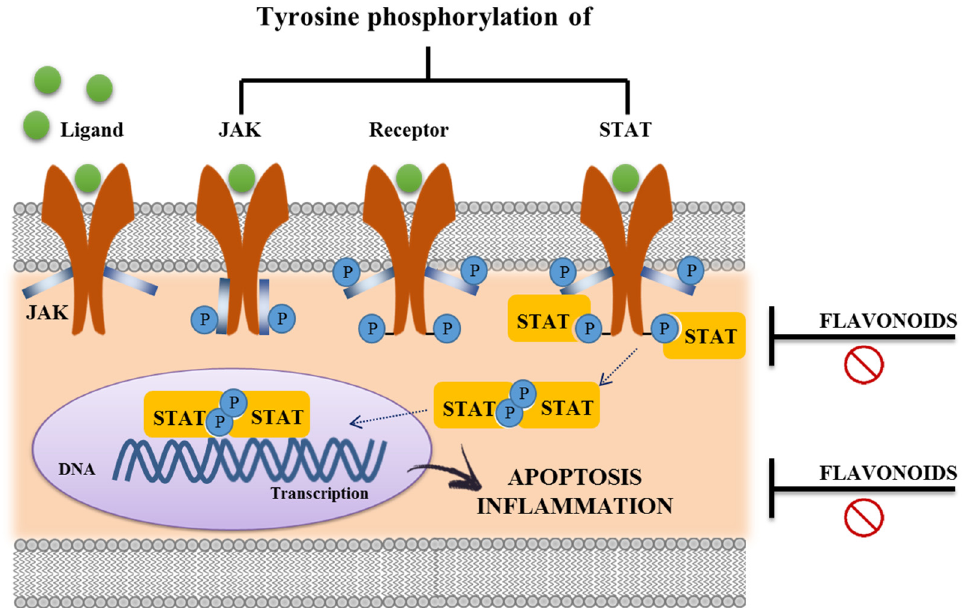
Figure 7. JAK-STAT signaling pathway. Upon the binding ligand, receptor-associated Janus Kinases (JAKs) become activated and mediate phosphorylation of specific receptor tyrosine residues. This leads to the recruitment of specific STATs (Signal Transducers and Activators of Transcription), which are then also tyrosine-phosphorylated. Activated STATs are released from the receptor, they dimerize and translocate to the nucleus to bind target genes associated with proliferation, differentiation and survival of the cells, including immune cells. The inhibition of JAK-STAT signaling pathway by flavonoids treatments leads to an immunomodulatory effect.